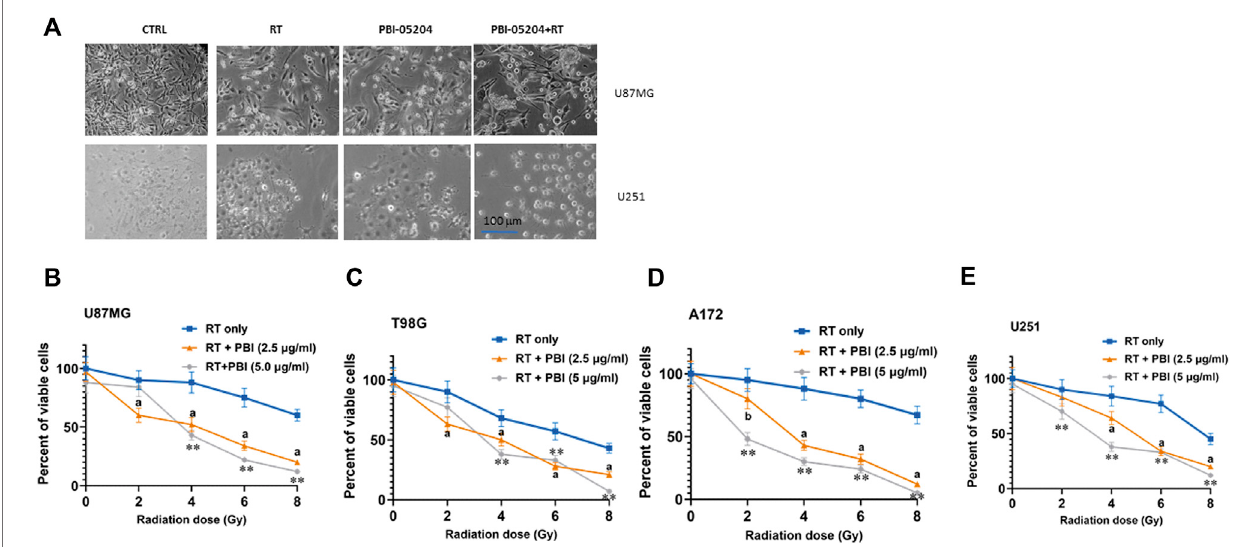
FIGURE 1 | Short term viability/cytotoxicity effects of PBI-05204 with RT in human GBM cell lines. (A) Morphological changes of U87MG and U251 cells cultured with 5.0 μ g/ml PBI-05204 with or without RT 4 (Gy) after cells were treated for 72 h. (B – E) Percentage of viable cells from U87MG, T98G, A172 and U251 cell lines, respectively, after treatment with RT alone or RT in combination with PBI-05024 (2.5 and 5.0 μ g/ml). Data are presented asmean ± SD of quintuplicate wells. a p < 0.01, b p < 0.05 PBI-05204 (2.5 μ g/ml) + RT vs RT only; ** p < 0.01 PBI-05204 (5 μ g/kg) + RT group vs RT only.